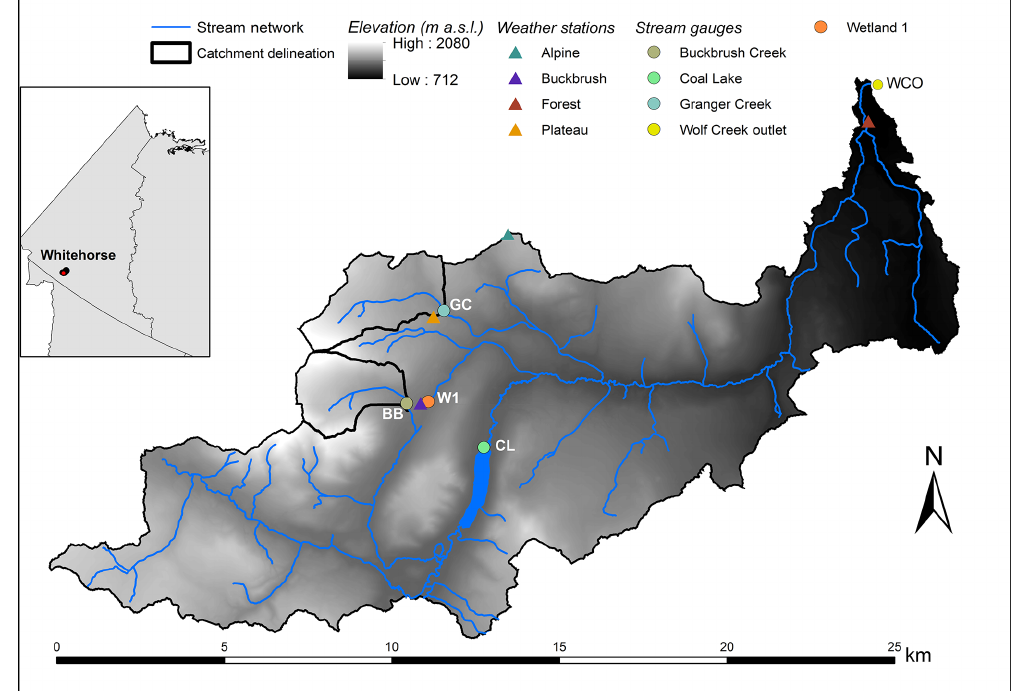
Figure 1. Map of Wolf Creek Research Basin (WCRB) with Buckbrush Creek (BB) and Granger Creek (GC) catchments delineated. All stream gauges (BB, GC, CL, W1 and WCO) are indicated using circles; weather stations within WCRB are shown as